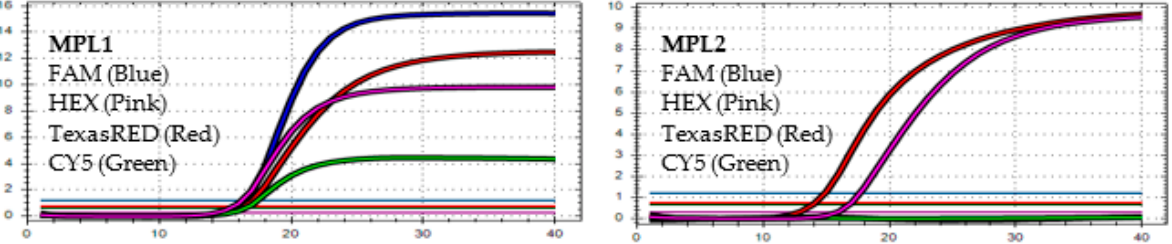
Figure 6. In MPL1 : No target failure is detected. In MPL2 , the target failure is detected in channel FAM. No amplification is detected in channel CY5 because of the competition of high viral load with the IC (human RNAse P). This pattern is identified as variant Delta